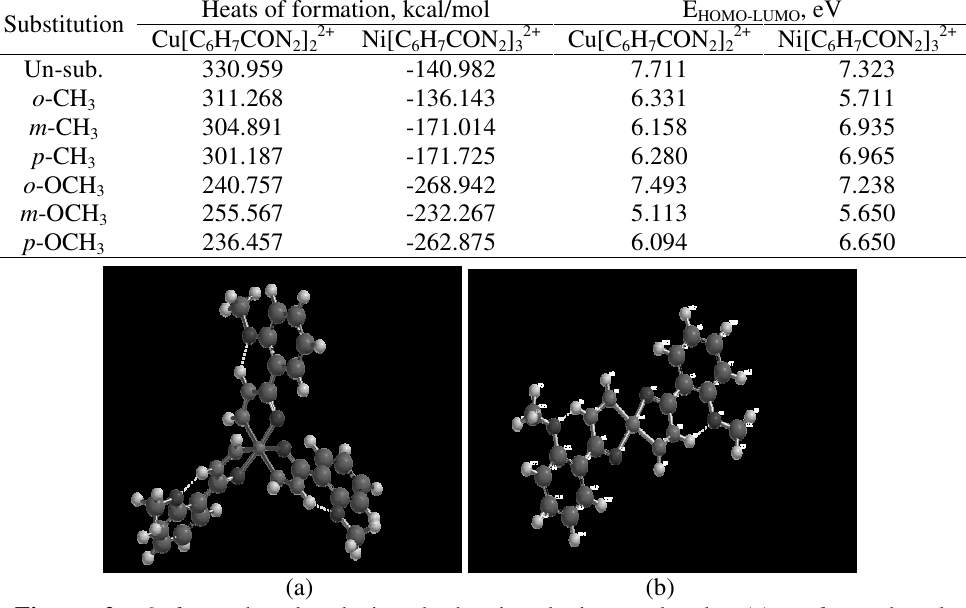
Figure 2. Ortho -methoxyl substituted showing hydrogen bonds, (a) ortho -methoxyl Ni[C H CON ] 32+ and (b) ortho-methoxyl Cu[C 6 7 2